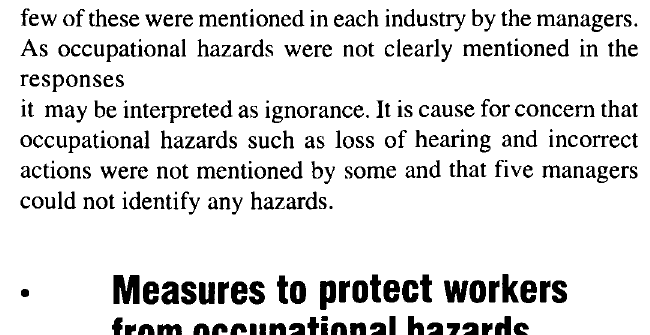
Table 4: Addressing occupational hazards in an industry (N=14)